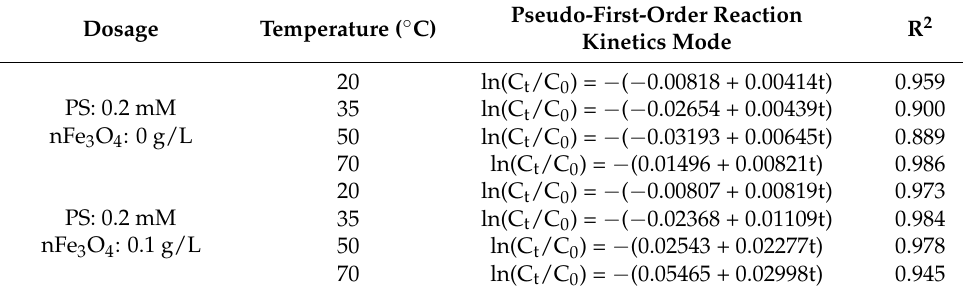
Table 4. The kinetic parameters of BPA degradation at different temperatures. Figure 4. ( a ) The effect of temperature on BPA removal; ( b ) Tthe kinetic of BPA degradation at different temperature. Conditions: pH = 6.8, [BPA] = 5 mg/L. Pseudo-First-Order Reaction Dosage Temperature ( ◦ C) Kinetics